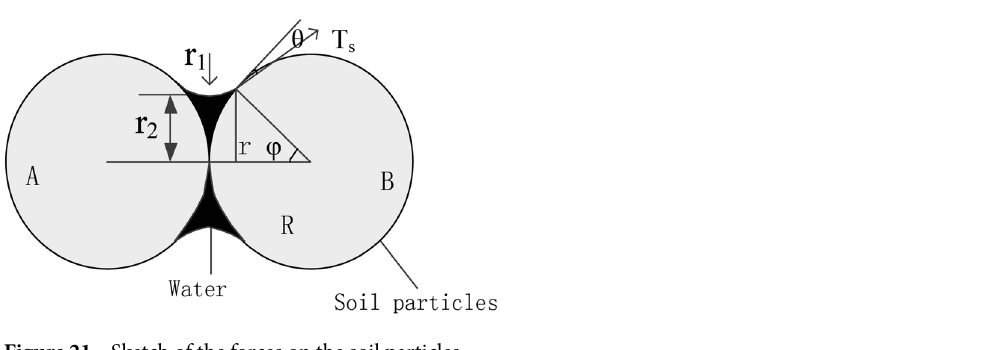
Figure 21. Sketch of the forces on the soil